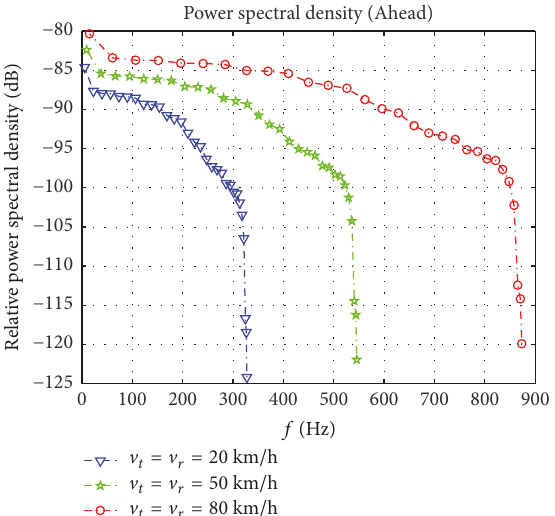
Figure 7: Behavior of PSD 𝑆(𝑓) presented in (10) and Figure 3(a) for V2V scenarios with different moving speeds of Tx/Rx vehicles.